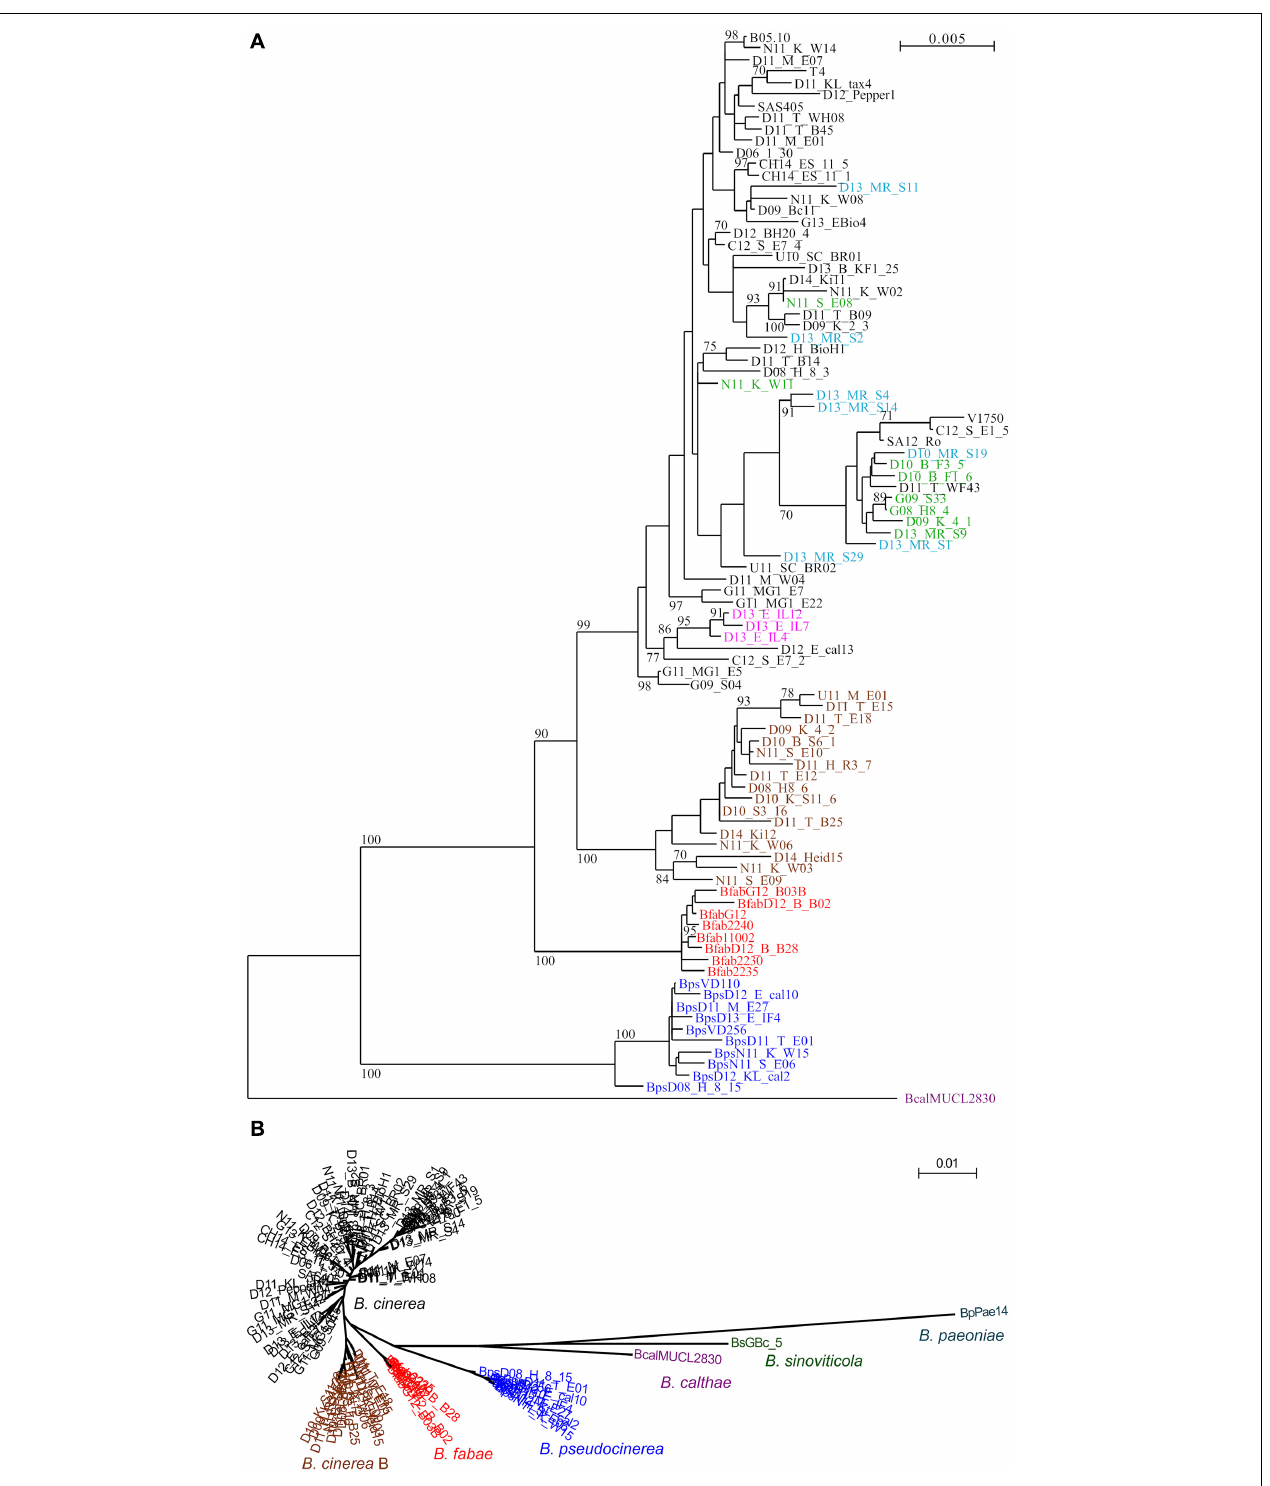
FIGURE 1 | (A) PhyML-generated tree of 93 Botrytis strains, based on concatenated sequences of genes MLST1–MLST10, with 9524 nucleotides compared. Bootstrap values > 70 based on 1000 replicates are shown. Bcal (purple): B. calthae ; Bps (blue): B. pseudocinerea ; Bfab (red): B. fabae . B. cinerea group B (brown); B. cinerea Iris isolates (pink). B. cinerea strawberry isolates previously described as “group S” (Leroch et al., 2013) are shown in green, and B. cinerea strawberry isolates with multiple fungicide resistances are shown in light blue. (B) Circular PhyML tree including B. paeoniae and B. sinoviticola , illustrating genetic separation of all species, and of B. cinerea group B from other B. cinerea